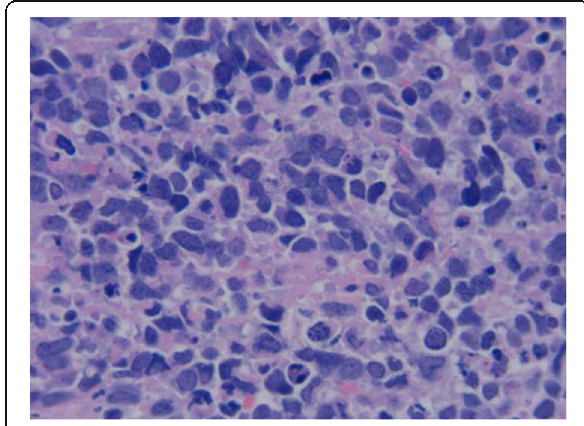
Fig. 2 On cytological examination, the exhibits reduced cytoplasm; the cytoplasm contains the nucleus on one side with red-stained protrusions, at the defect site with invagination and red staining, or with red stains in the area surrounding the nucleus and clear boundaries